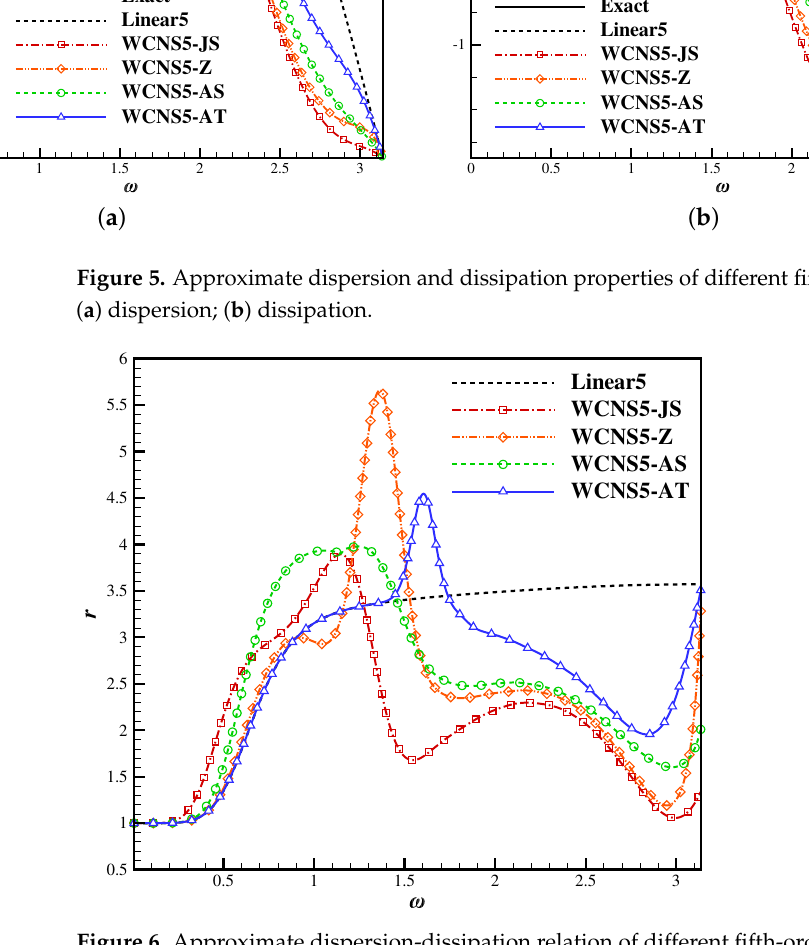
Figure 6. Approximate dispersion-dissipation relation of different fifth-order WCNS